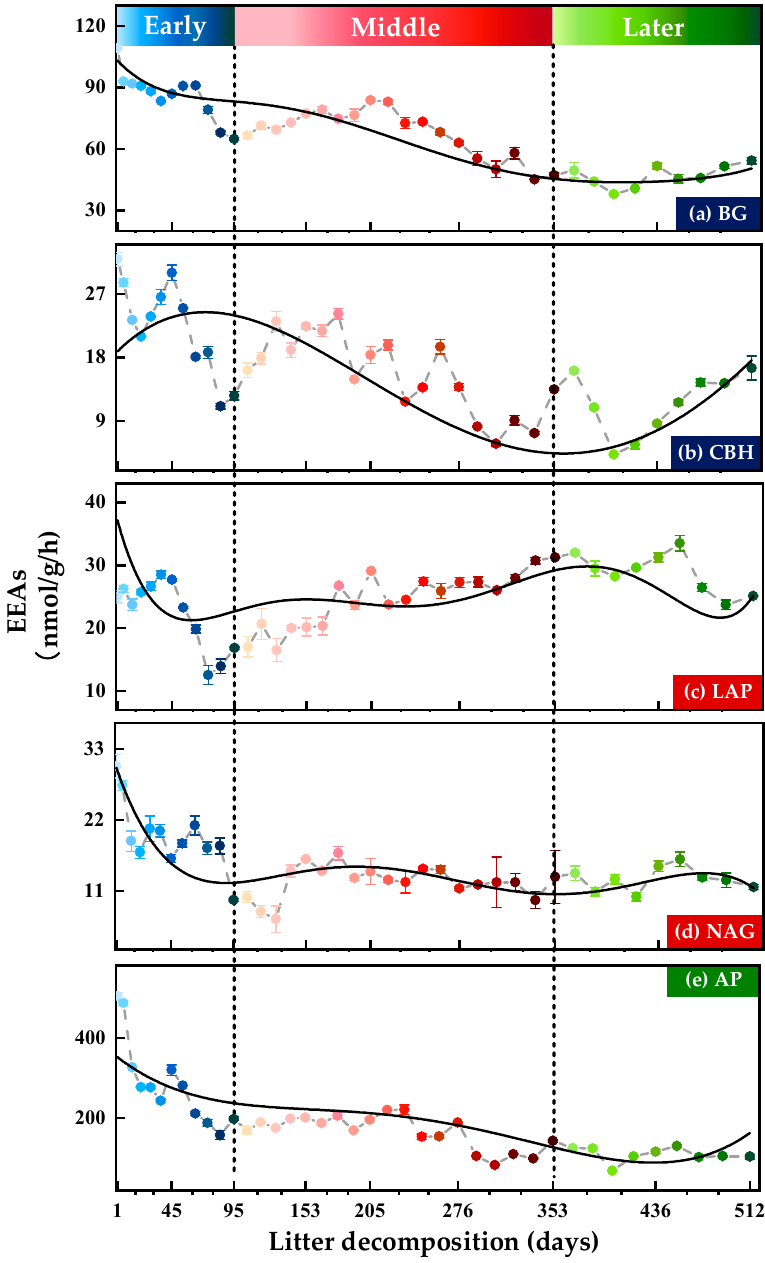
Figure 1. The variations of soil extracellular enzyme activities (EEAs) during the plant residue transformation. ( a ) BG, β -1,4-glucosidase; ( b ) CBH, cellobiohydrolase; ( c ) NAG, β -N-acetylglucosaminidase; ( d ) LAP, leucine aminopeptidase; ( e ) AP, acid phosphatase. The extracellular enzyme activities are expressed as the mean ± SE. The dashed lines in the graph represent the actual variation rules. The solid lines are the fitted curves, BG: R 2 = 0.97 ***; CBH: R 2 = 0.95 ***; LAP: R 2 = 0.59 ***; NAG: R 2 = 0.58 ***; AP: R 2 = 0.89 ***. *** p < 0.001.